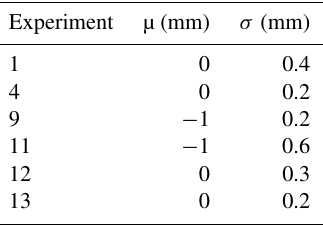
Table 1. The mean value ( µ ) and the standard deviation ( σ ) of the vertical difference between duplicate DEMs for each experiment.